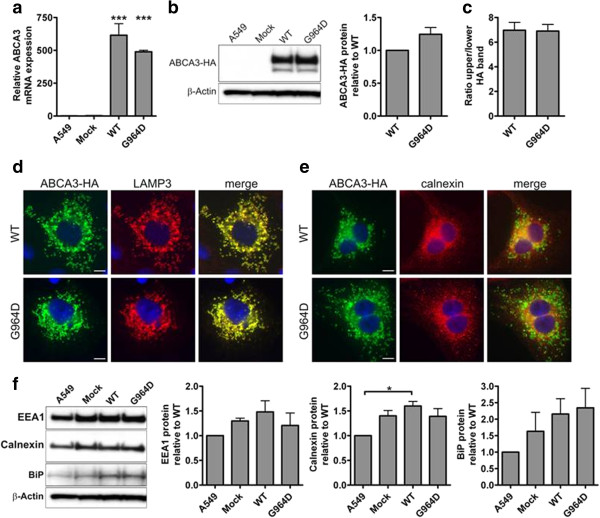
Cellular effects of 48 h transient ABCA3 expression in A549 cells. a. ABCA3 mRNA expression levels analyzed by quantitative real time PCR (P < 0.001 for WT/G964D vs. A549/Mock). b. Western immunoblot analysis of HA-tagged ABCA3 in total cell lysates. β-actin was used as a loading control. c. Ratio of the upper/lower ABCA3 processing form. d. Co-immunostaining of HA-tagged ABCA3 with the lysosomal (lamellar body) marker LAMP3. e. Co-staining of HA-tagged ABCA3 with the ER marker calnexin. f. ER (calnexin, BiP) and early endosome markers (EEA1) in cells transiently transfected with ABCA3. β-actin was used as a loading control. Scale bars 7.5 μm, *P < 0.05.